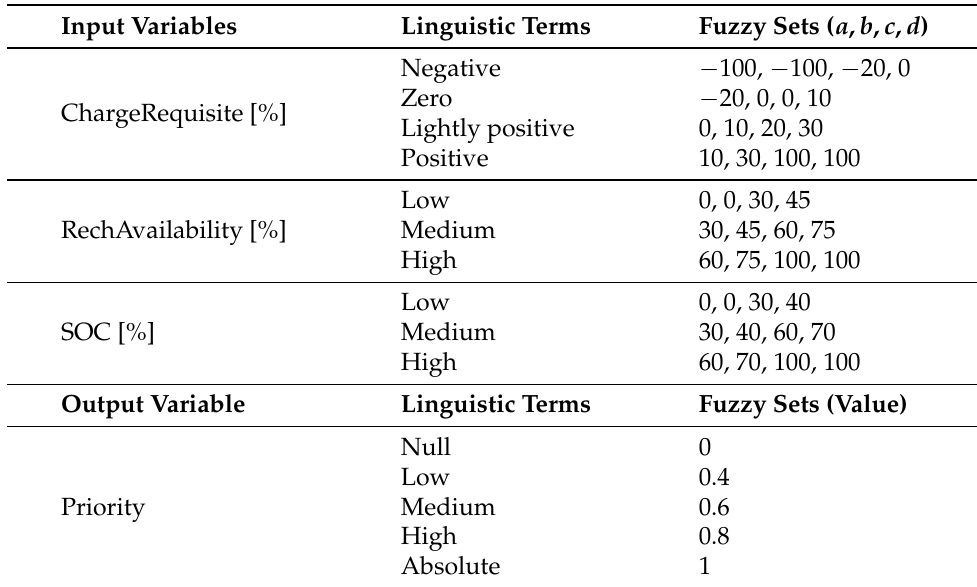
Table 2. Fuzzy sets of the input and output variables: linguistic terms and their corresponding trapezoidal fuzzy set parameters.